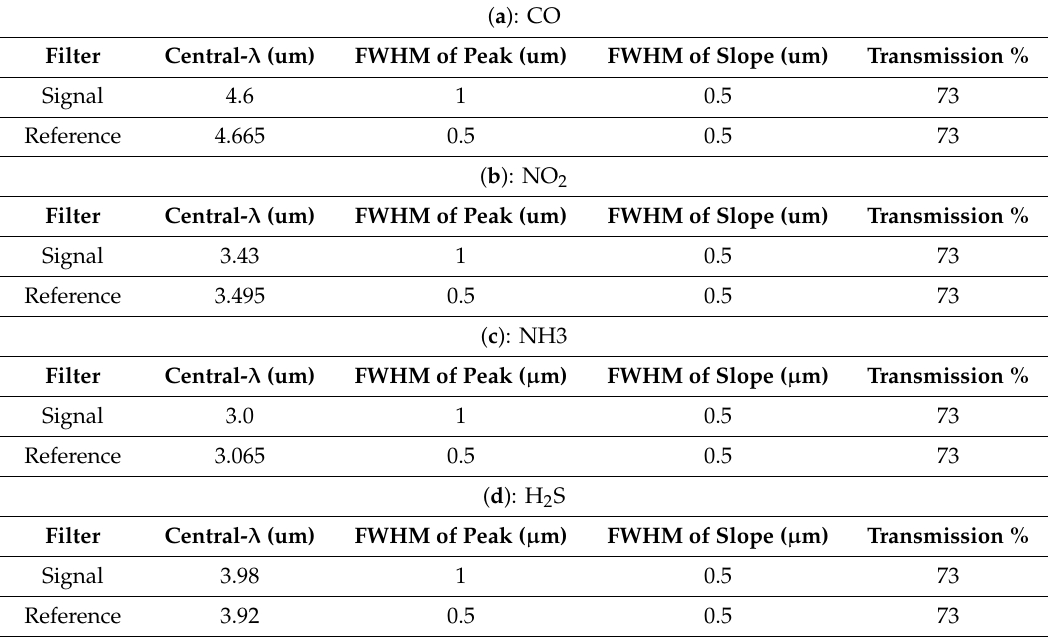
Table 3. Modelled ideal fixed filter specifications for both signal and reference filters for the various gases of